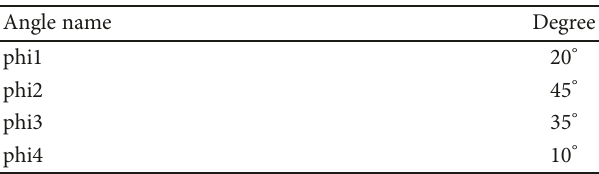
Table 1: Angular measures of support for neutral position of the hand (for parameter signi fi cance, see Figure